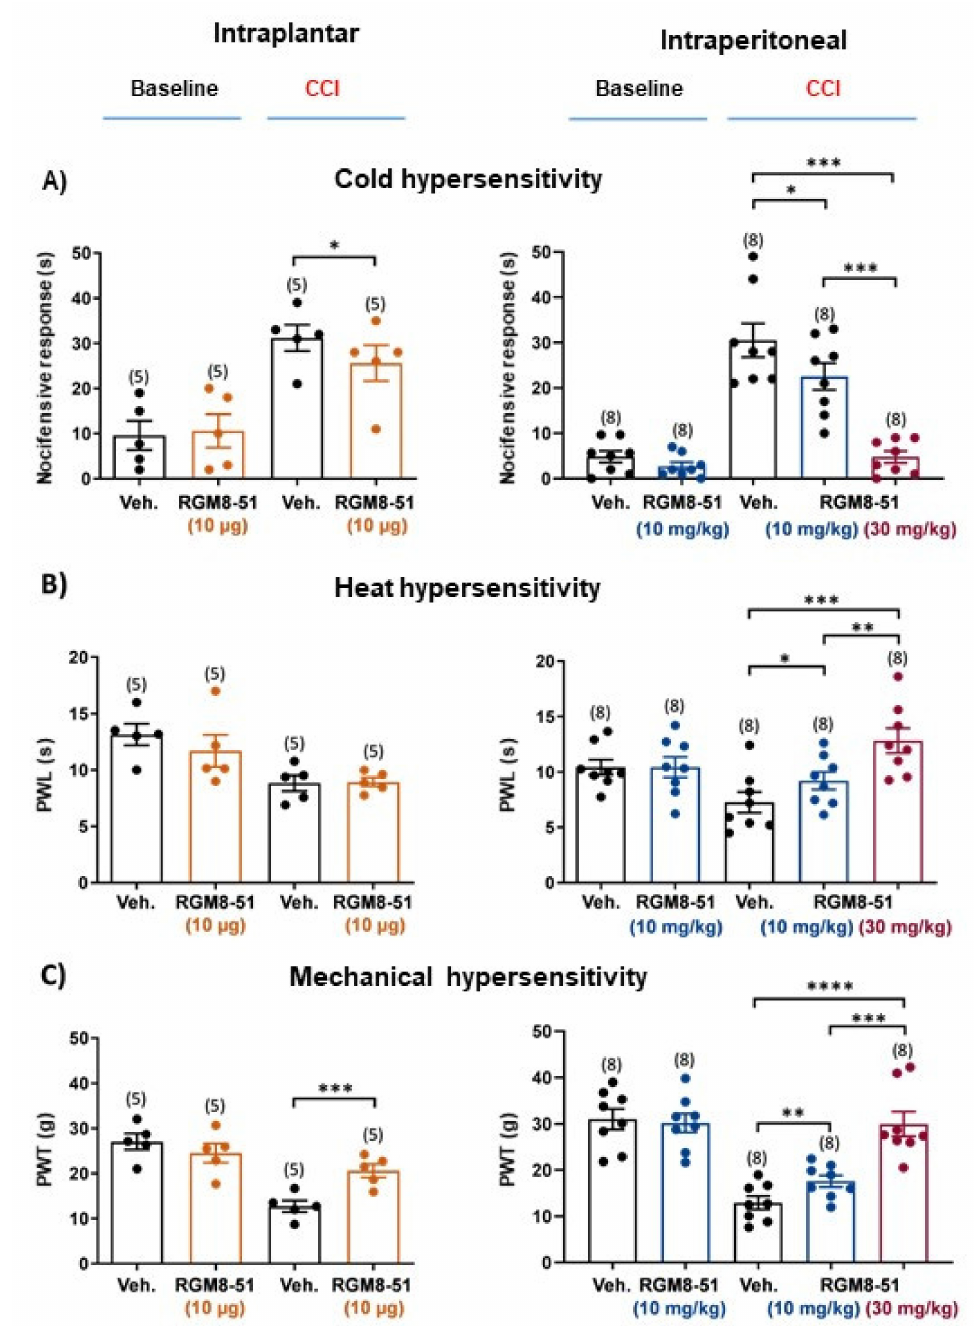
Figure 7. Effects of compound RGM8-51 on cold, heat and mechanical hypersensitivity in the CCI model in the rat. RGM8-51 was administered before (baseline) and after CCI surgery (CCI) by both the intraplantar (10 µ g, left panels) and the intraperitoneal (10 and 30 mg/kg, right panels) routes. Note that vehicle administration after CCI surgery was associated to an increase in the nocifensive response duration to acetone application, and to reductions in the paw withdrawal latency (PWL) to heat radiation and the paw withdrawal threshold (PWT) to tactile stimulation of the injured hind paw, indicative of cold ( A ), heat ( B ) and mechanical ( C ) hypersensitivity, respectively. Data are mean ± SEM of the number of animals specified between parentheses. Statistical analysis was performed by using the paired t -test. * < 0.05; ** < 0.01; *** < 0.001; **** < 0.0001 with regard to vehicle (Veh.) or between the two i.p.